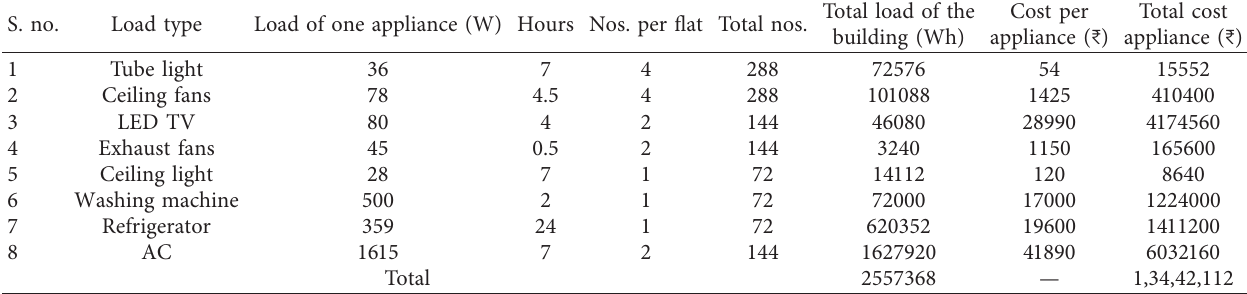
Table 3: Load calculation—conventional—2BHK.